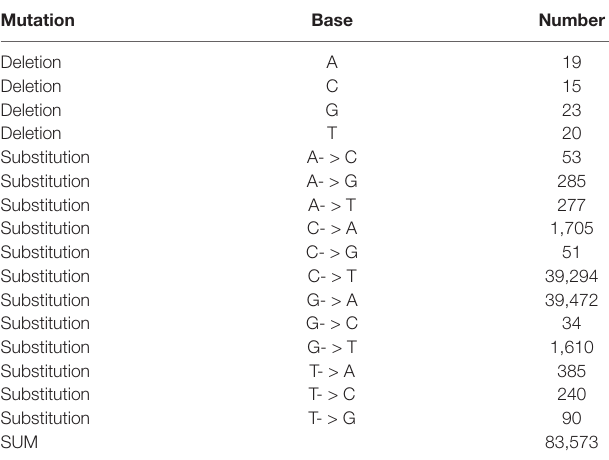
TABLE 1 | Types of mutations and their frequencies detected in the 81 mutant lines for a minimum base coverage of